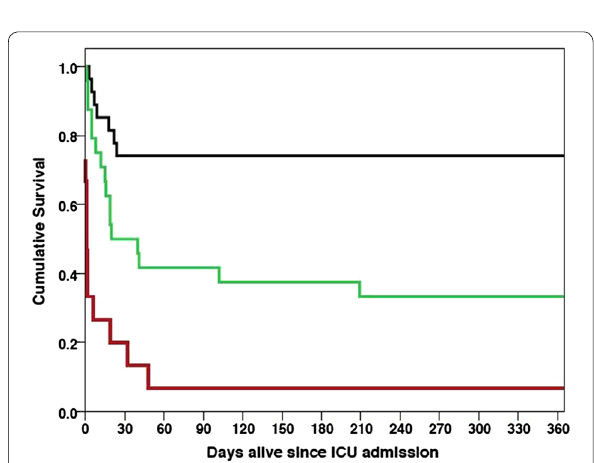
Fig. 4 Kaplan–Meier survival curve stratified by ABC at ICU admission. Black lines ABC ABC Lactate class 2 ( n + 15). Log-rank p value